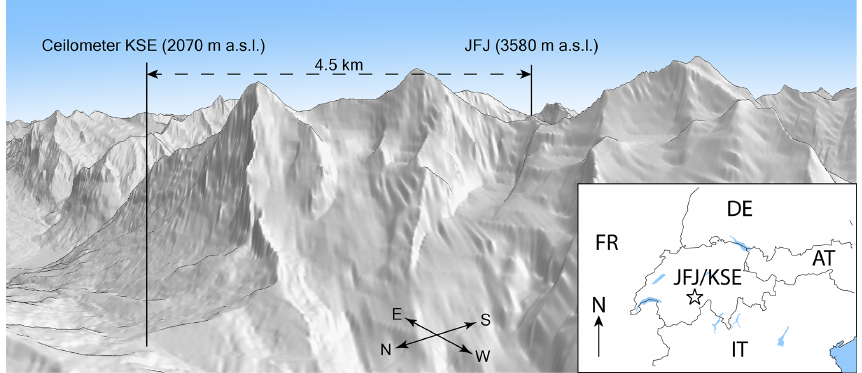
Figure 1. Illustration of the location of the INP sampling location at JFJ and the ceilometer at the Kleine Scheidegg (KSE) embedded within the topography and in Switzerland. The topography was extracted from the digital height model DHM25 from the Federal Office of Topography